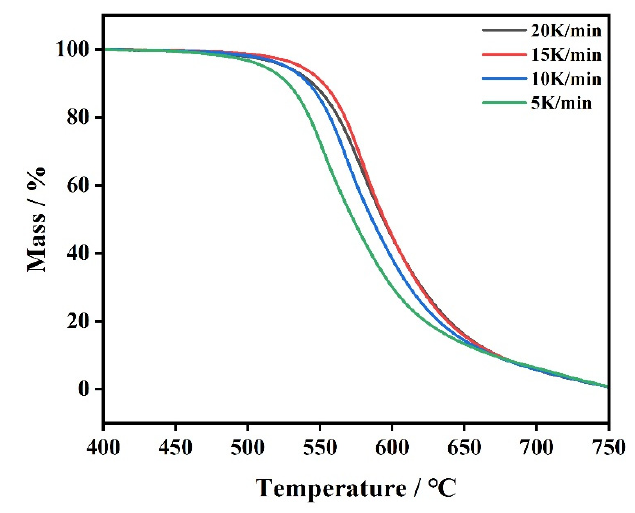
Figure 7. Multivariate nonlinear fitting results of polyimide. Table 3. Multivariate nonlinear fitting results based on the Friedman method.